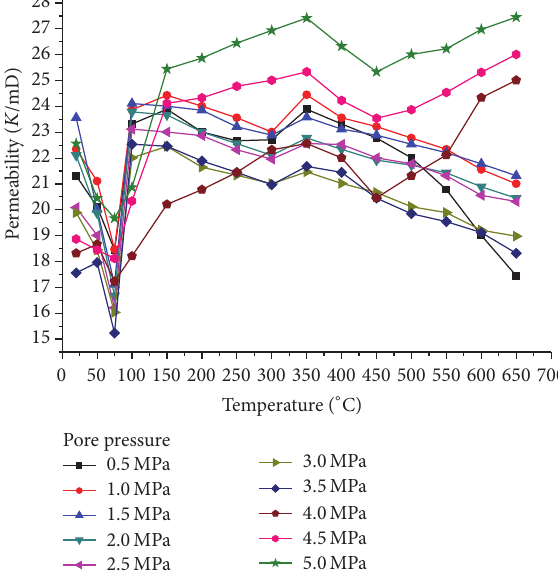
Figure 10: Variations of permeability of lignite at different temper- atures and pore